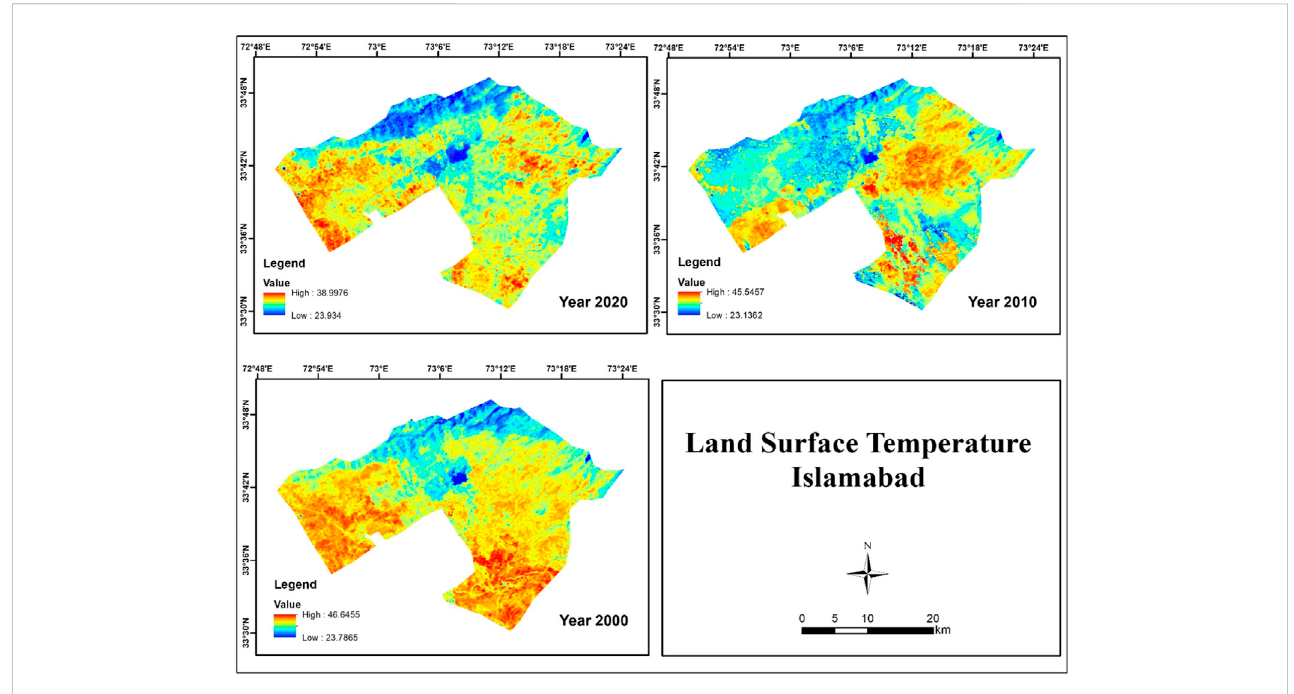
FIGURE 6 LST comparison map for the years 2000, 2010, and